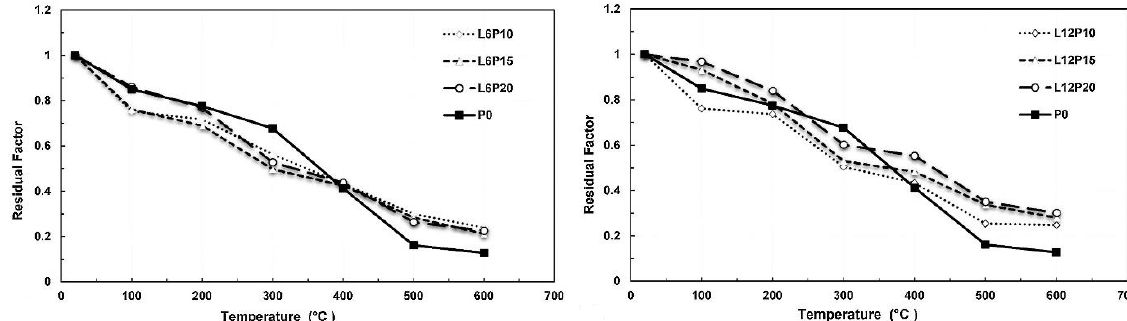
Figure 11. Variations in residual compressive strength of conventional and polypropylene-reinforced concrete with rising temperature, where L denotes the length of polypropylene fiber, i.e., 6 and 12 mm, while P denotes the volume fractions of polypropylene fiber, i.e., 1, 1.5, and 2 kg/m 3 . Copyright permission is obtained from [140].